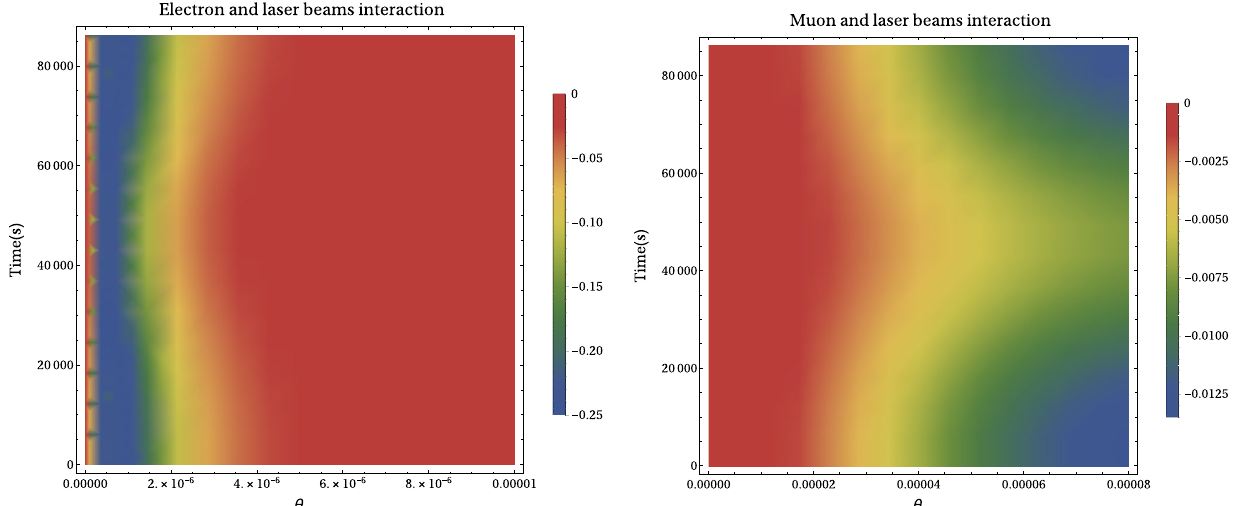
Fig. 1 FC phase (cid:2)φ | LV (left panel) for the electron beam (right panel) muon beam, interacting with the laser beam in the time versus θ plane with ϕ = χ = π